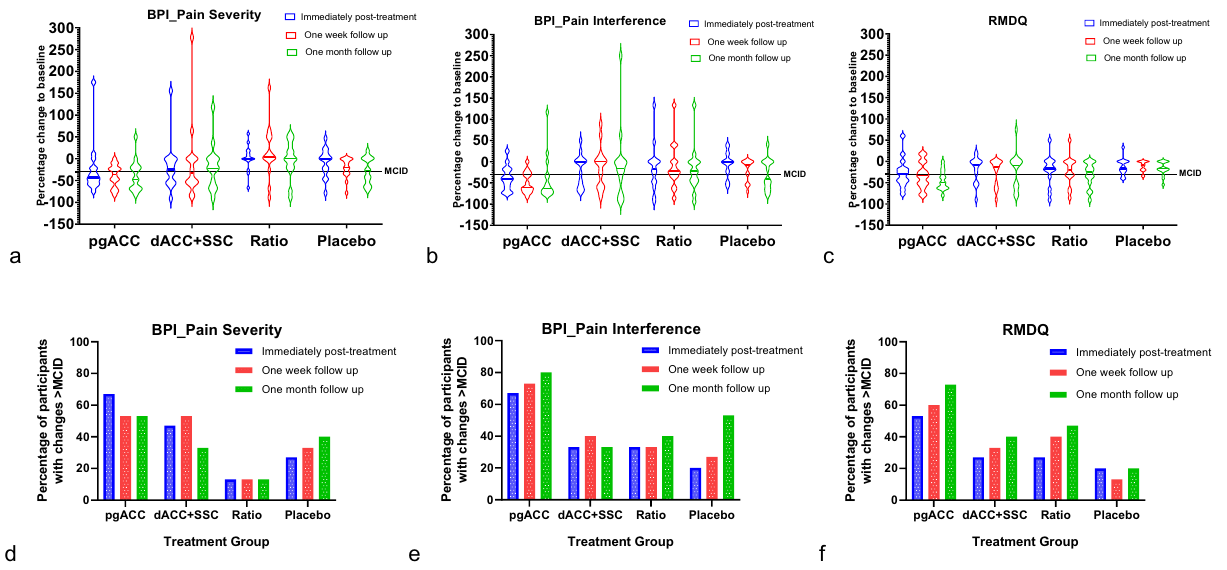
Figure 5. Violin plots for percentage change to baseline in pain severity ( a ), pain interference ( b ), and disability ( c ), and the proportion of participants demonstrating clinically meaningful reductions in pain severity ( d ), pain interference ( e ), and disability ( f ) expressed as percentage. pgACC: pregenual anterior cingulate cortex, dACC: dorsal anterior cingulate cortex, SSC: primary somatosensory cortex, BPI: Brief pain inventory, RMDQ: Roland Morris Disability Questionnaire, MCID: Minimal clinically important difference. The thick line in each of the violine plots ( a – c ) represents the EEG measures. Descriptive data for CD and FC measures at all time points are presented in Supplementary Tables S2 and S3 online. The CD values at the targeted brain regions (pgACC, dACC, and SSC), were comparable across treatment groups, with no changes observed across all time points. The FC measures demonstrated trend toward increased connectivity between the targeted brain regions in the treatment groups when compared to the Placebo groups. Figure 6 presents the heat map for mean percentage changes to baseline in FC between the targeted brain regions (pgACC, dACC, and SSC). At 1-month follow-up, the pgACC group demonstrated the highest magnitude of increases in FC, particularly in ISF1 and ISF3 bands.